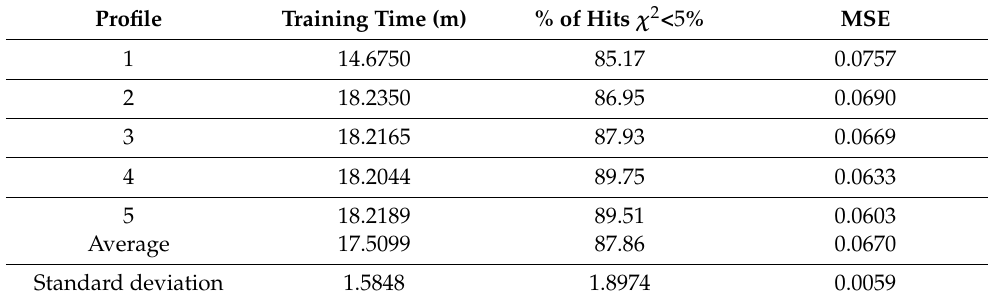
Figure 10. Cross-validation model. Table 9. Cross-validation results.